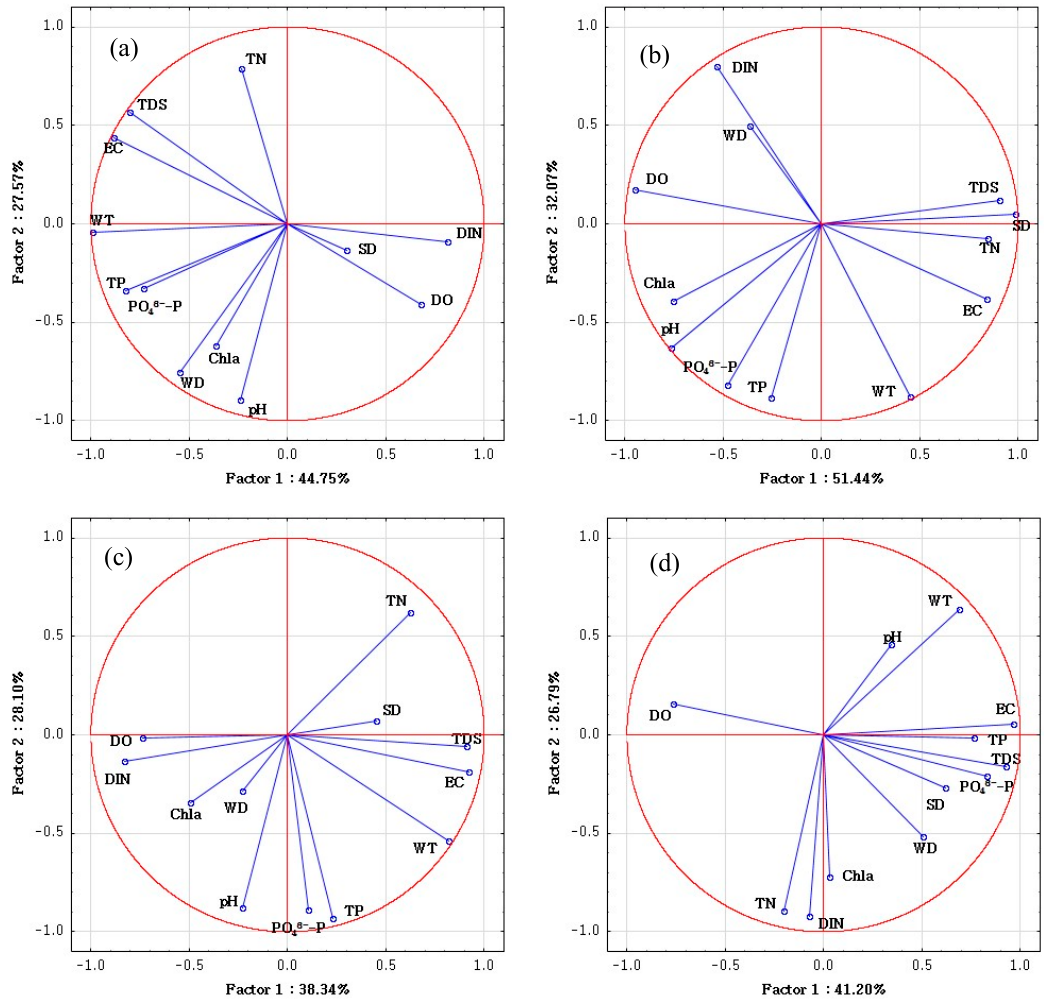
Figure 4. ( a ) PCA of cluster 1 of spatial CA; ( b ) PCA of cluster 2 of spatial CA; ( c ) PCA of cluster 3 of spatial CA; ( d ) PCA of cluster 4 of spatial CA.